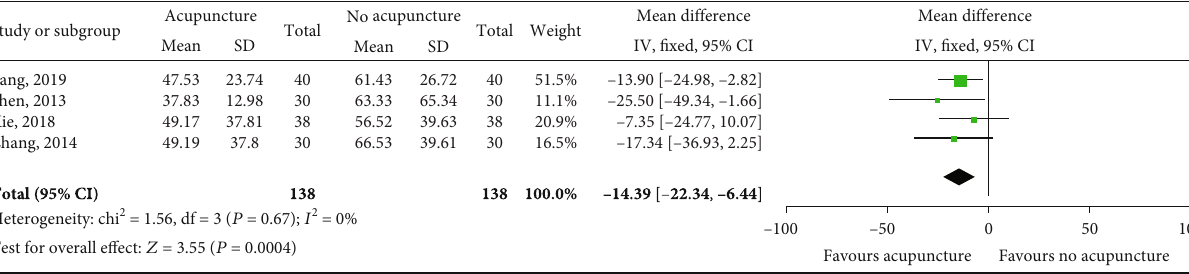
Figure 5: Impact of acupuncture on AST. Both I 2 and P represent the criteria for the heterogeneity test. ♦ : pooled mean di ff erence; — ■ — : mean di ff erence and 95% CI.